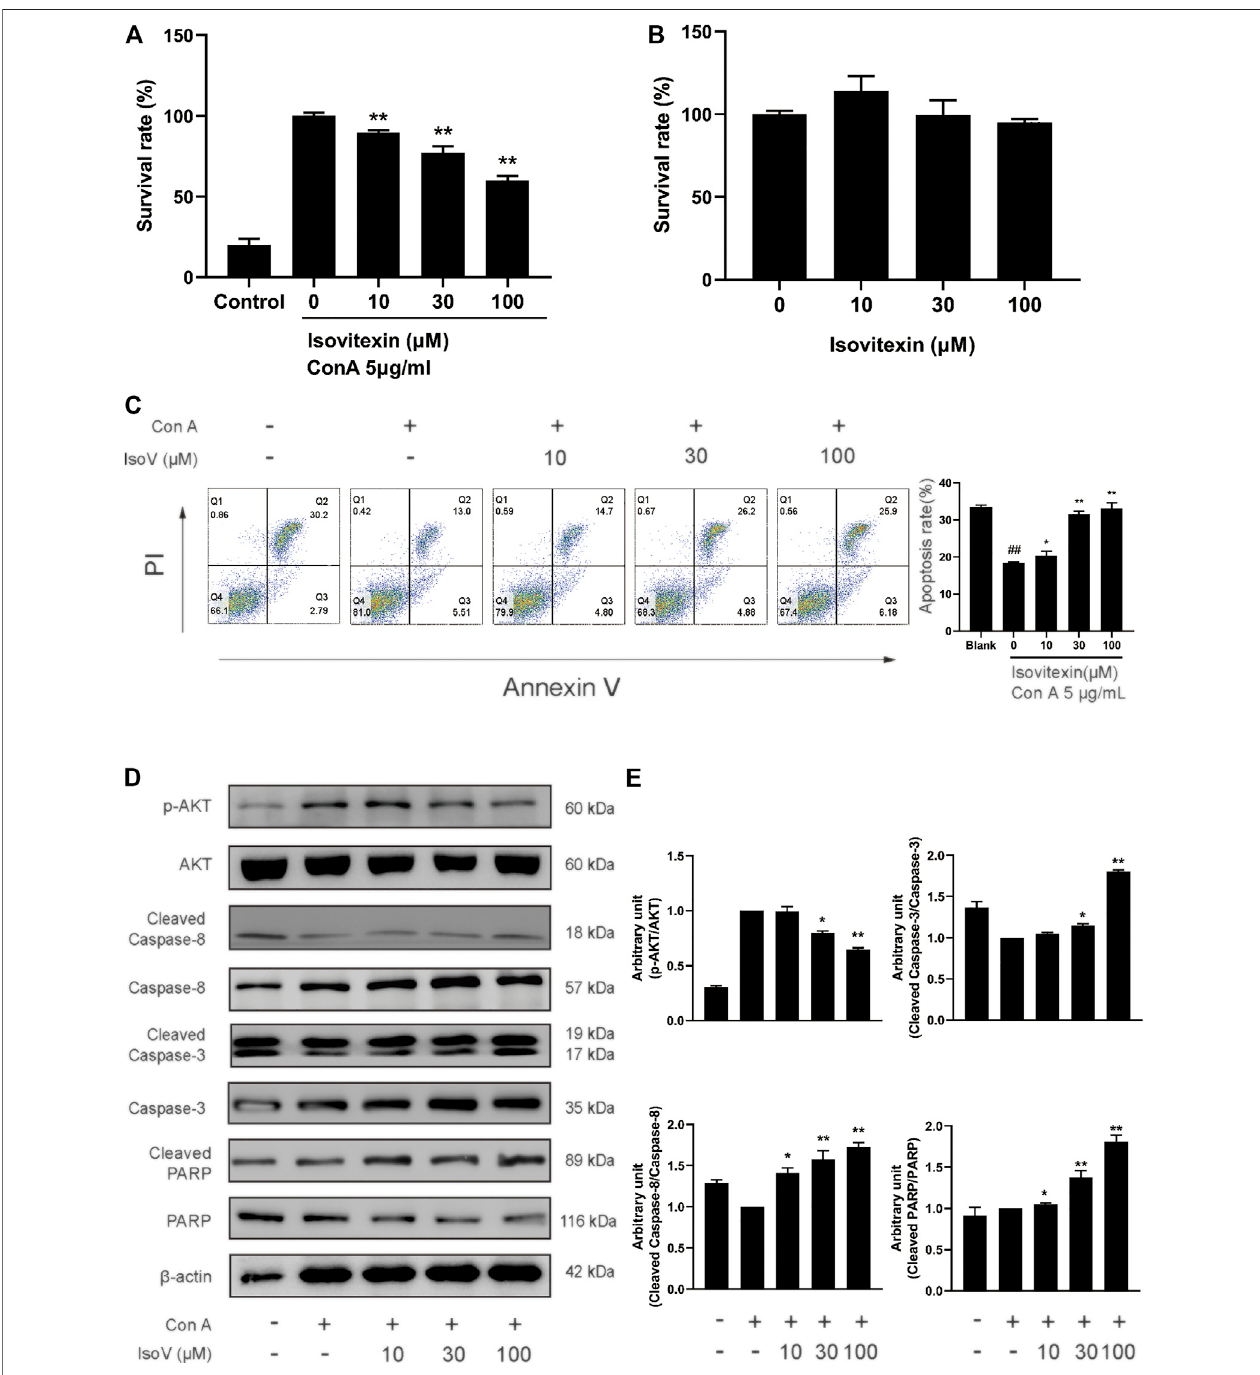
FIGURE4 | Isovitexininduces the apoptosis ofCon A-activated Tcells. (A) ConA-activated T cells weretreated withdifferent concentrationsofisovitexinfor 48 h, and the cell survival was determined by MTT assay. (B) T cells were treated with different concentrations of isovitexin for 24 h, and the cell survival was determined by MTT assay. Cells incubated without Con A and isovitexin were used as control. Con A-activated T cells were seeded in 12-well plates and incubated with 0, 10, 30 and 100 μ M isovitexin for 24 h. (C) Cells were stained with Annexin V and PI, and the apoptosis of the cells was determined by fl ow cytometry assay of Annexin V/PI staining. Annexin V positive cells of three independent experiments were shown in column statistics. (D,E) Cells treated with different concentrations of isovitexin were harvested and lyzed. The protein levels ofp-AKT, Cleaved caspase-3, Cleaved caspase-8, Cleaved PARP in Tcells were measured by western blotting, and the relative band density was analyzed using ImageJ. The grouping of gels were cropped from different parts of the different gels. Data represented mean ± SEM of three independent experiments. ## p < 0.01 vs. Blank group, * p < 0.05, ** p < 0.01 vs. control (Con A-activated T cells).